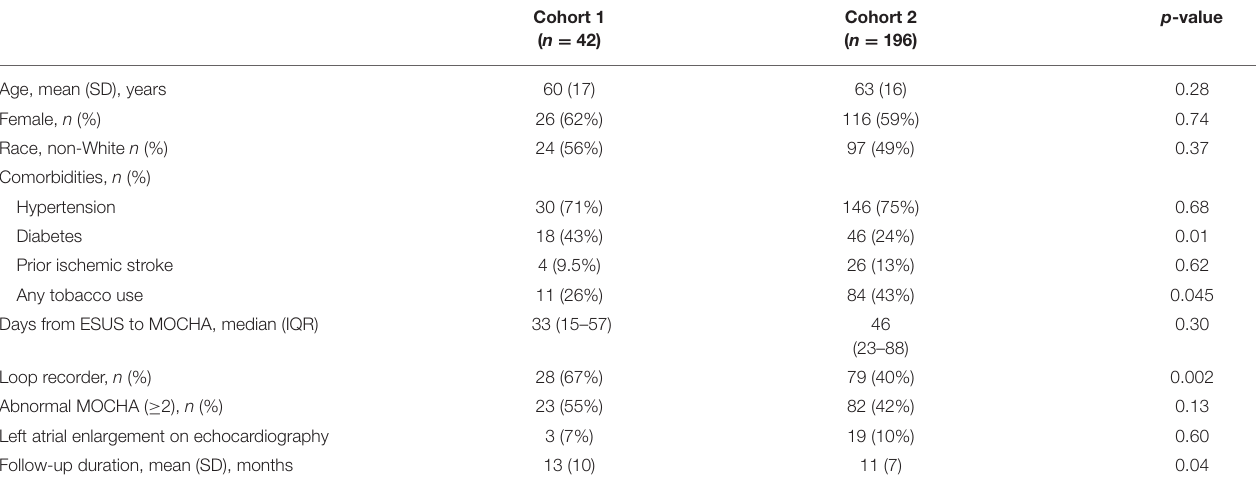
TABLE 1 | Baseline characteristics.